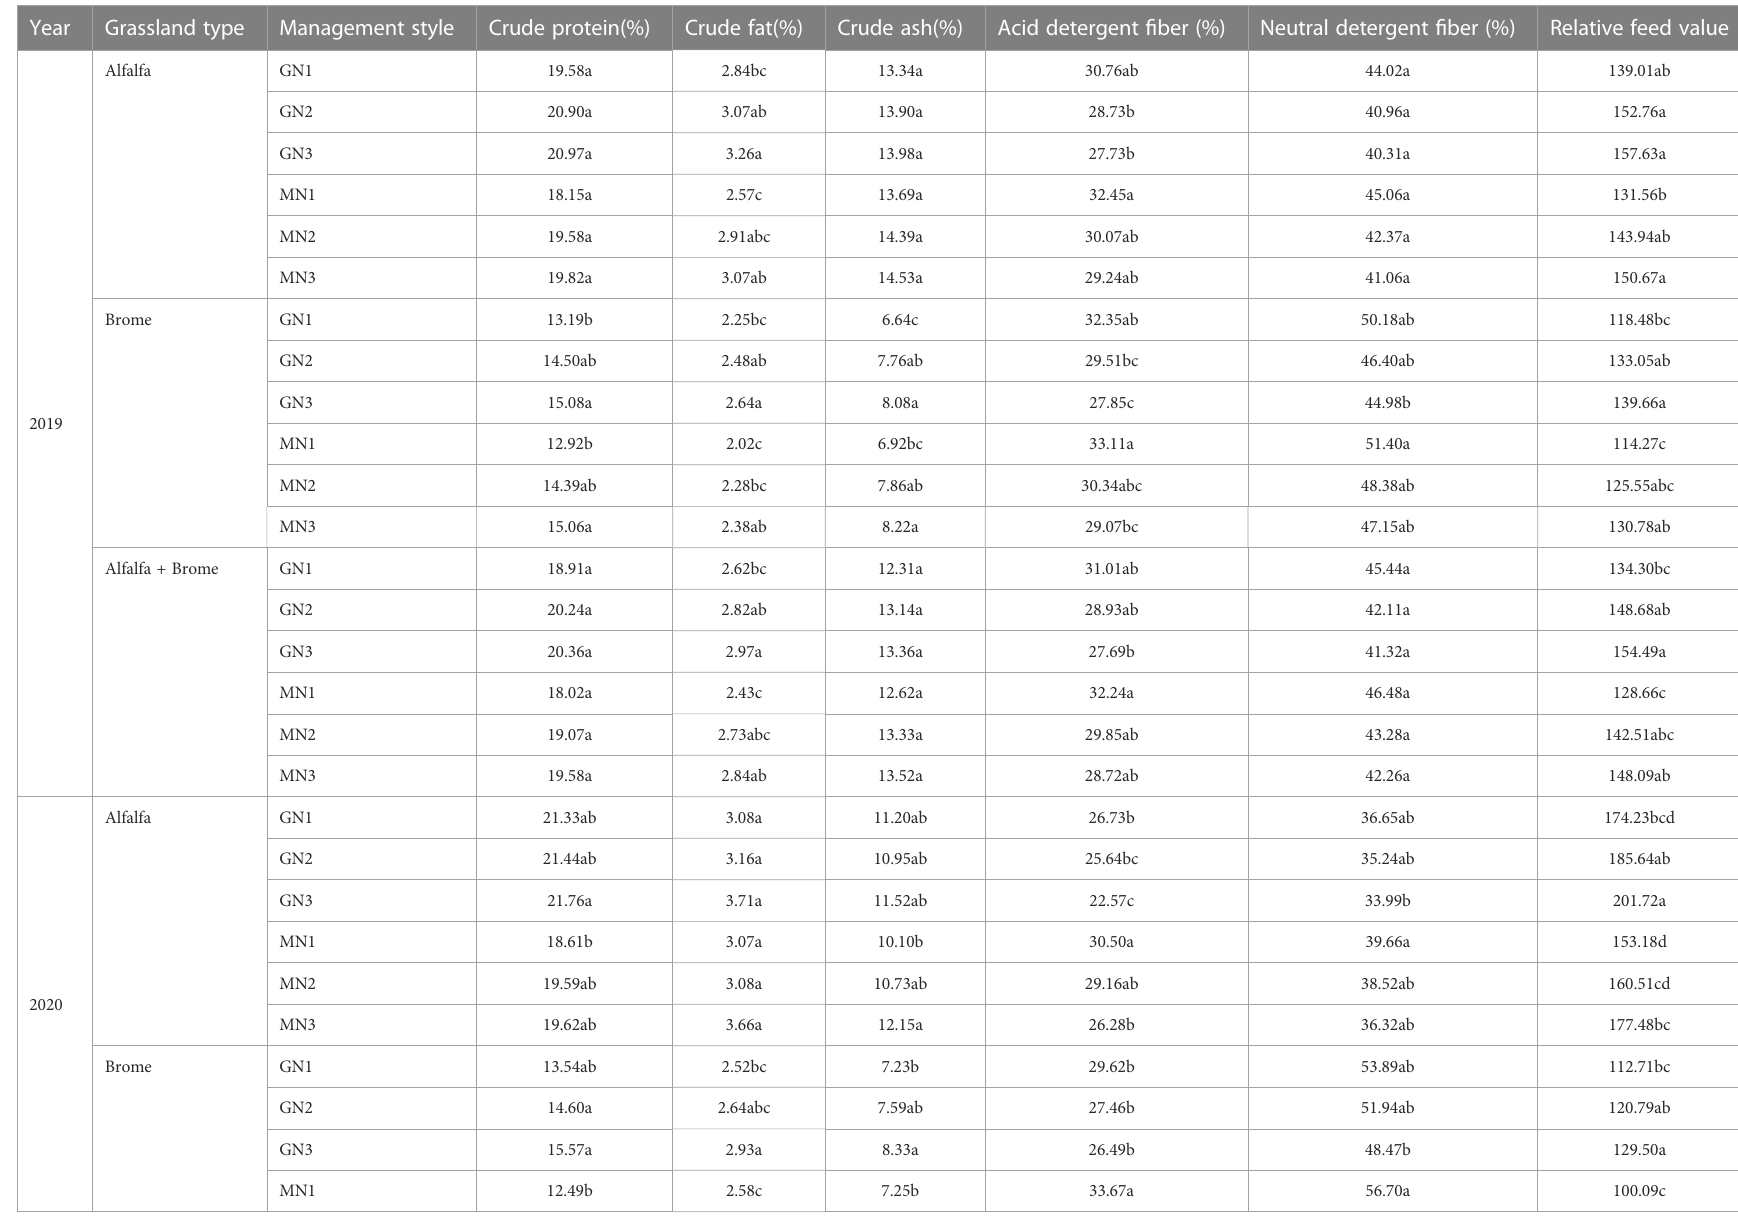
TABLE 2 The content of crude protein, crude fat, crude ash, acid detergent fi ber, neutral detergent fi ber and relative feed value of pasture under different treatments in 2019 and 2020.